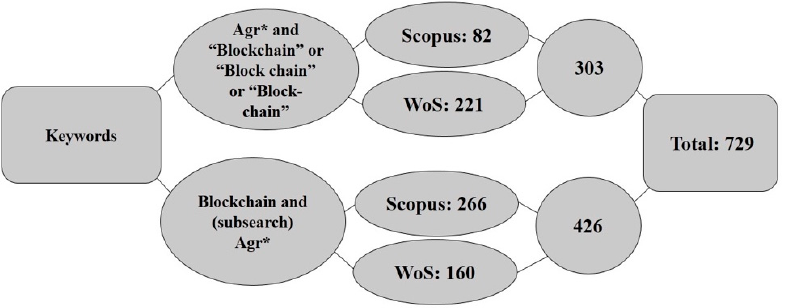
Figure 1. Search criteria and documents retrieved in Scopus and Web of Science databases.